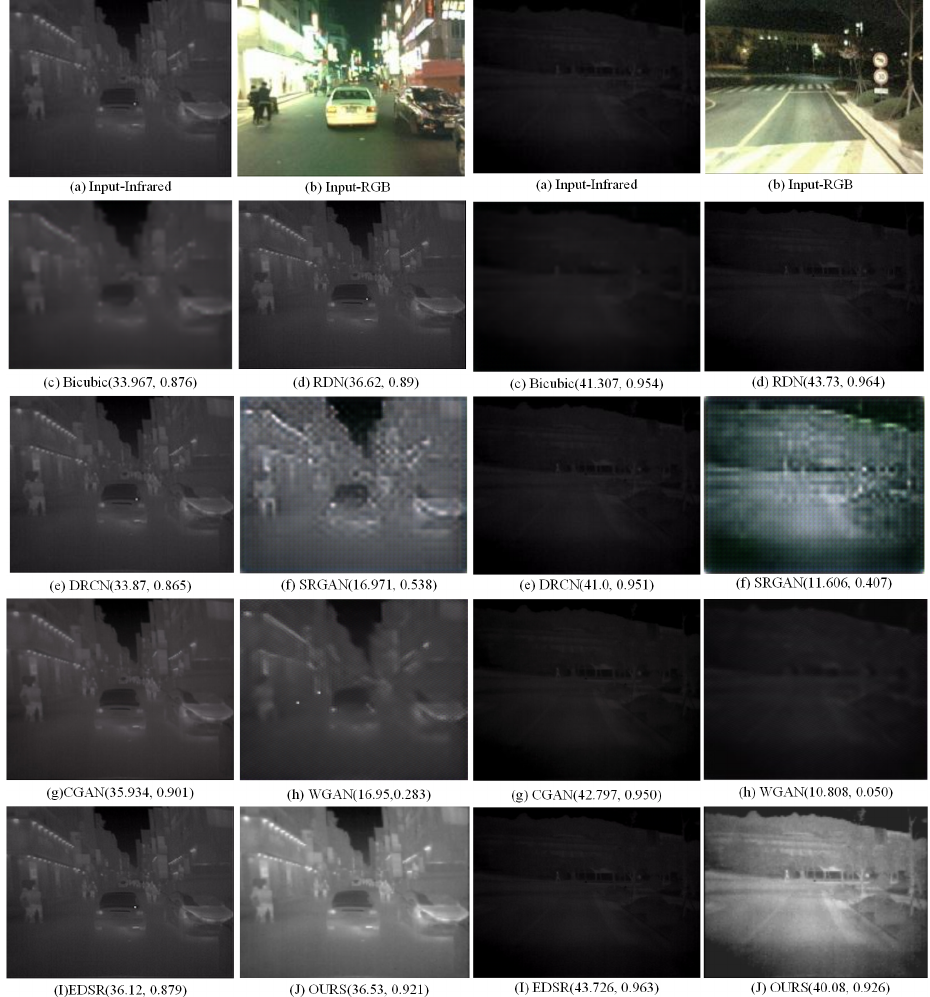
Figure 12. SR experiment results of scale 4 in night from KAIST